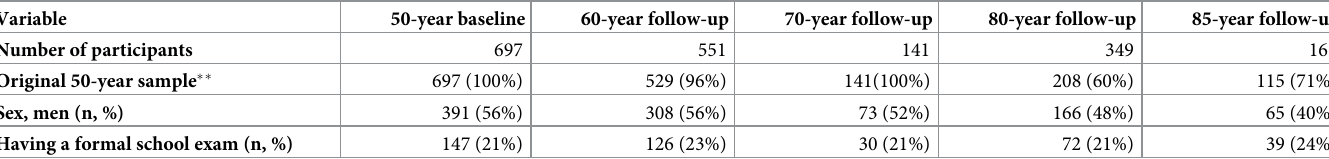
Table 1. Analysis sample for the WAIS IQs � .